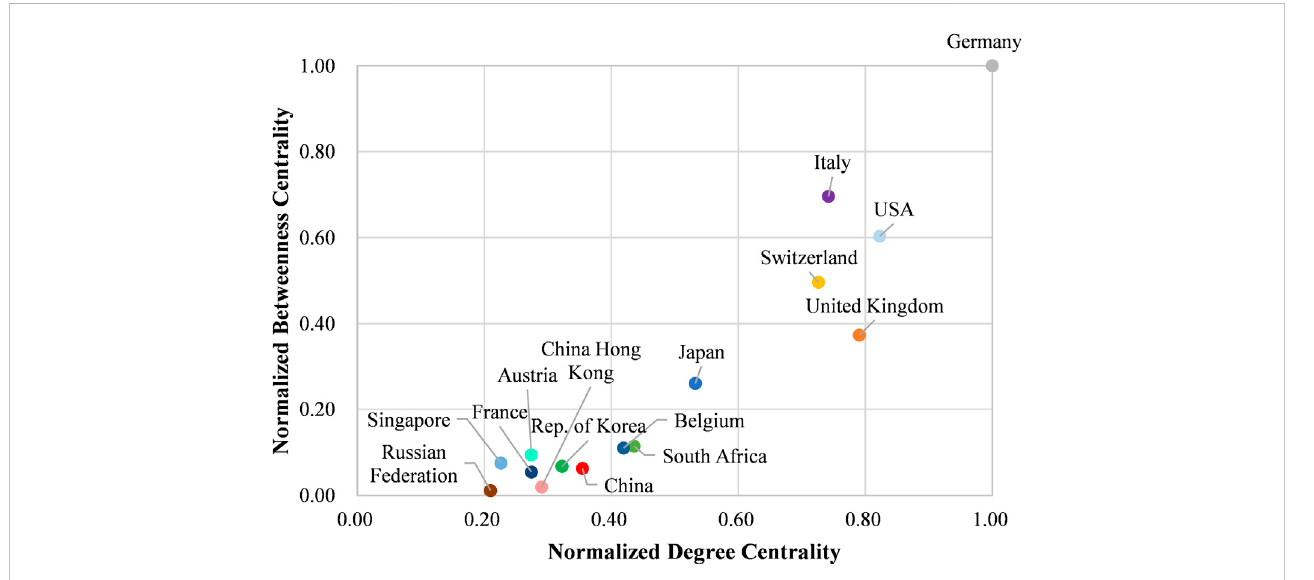
FIGURE 10 Country (area) position of the international platinum primary product trade